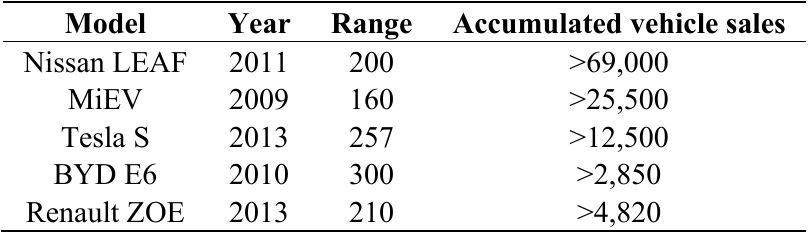
Table 2. Vehicle units range and global accumulated sales. Based on International Energy Agency (IEA) 2013 [27], manufacturer statistics and international import